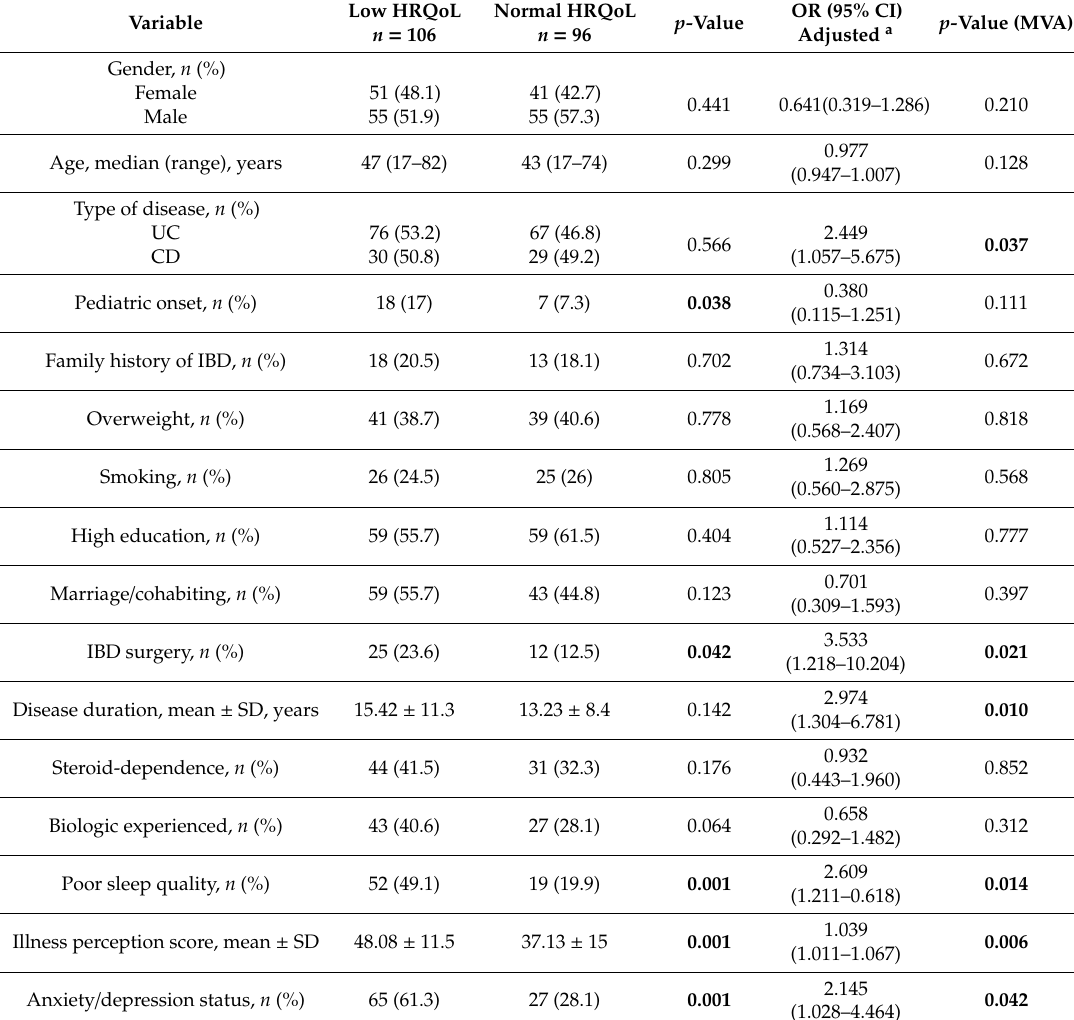
Table 2. Demographic and clinical characteristics of the 202 IBD patients in remission according to their health-related quality of life (HRQoL)